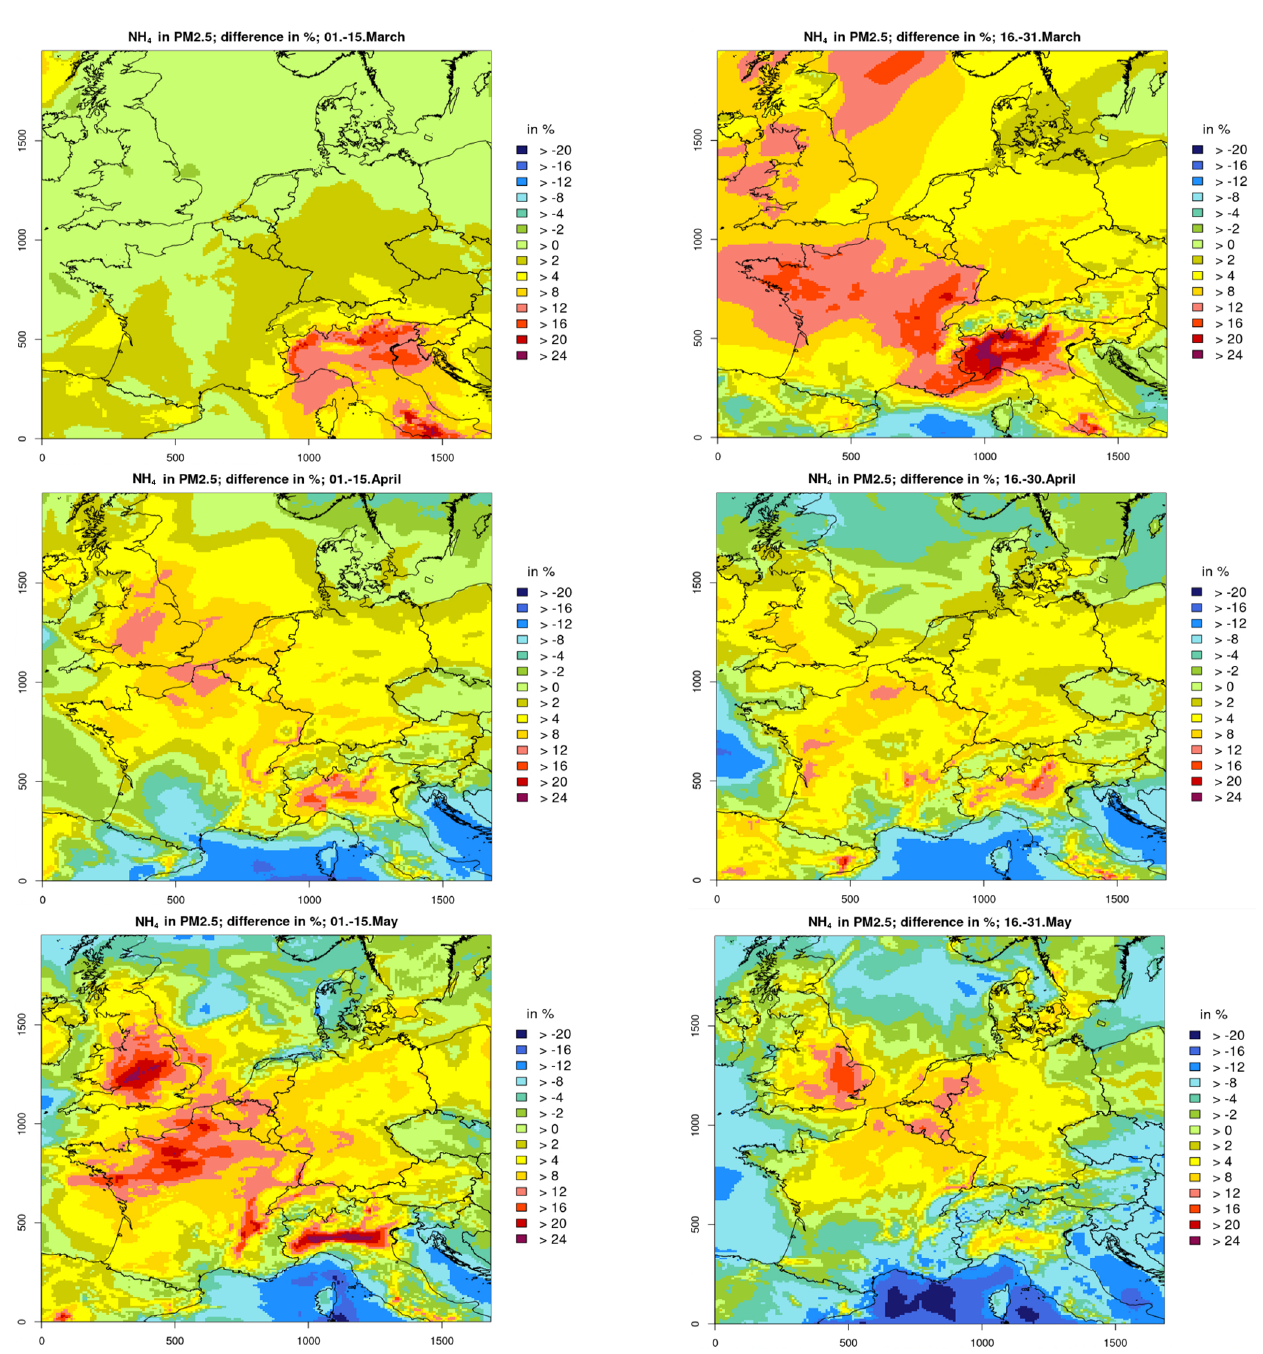
Figure A10. CMAQ results for relative particulate ammonium (NH + run) in central Europe between 1 March and 31 May 2020 in half-monthly intervals; positive values denote reductions.